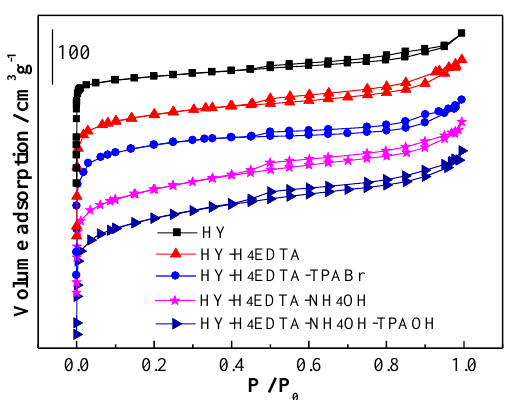
Figure 3. N 2 adsorption-desorption isotherms of the parent HY and the optimized hierarchical HY zeolites.